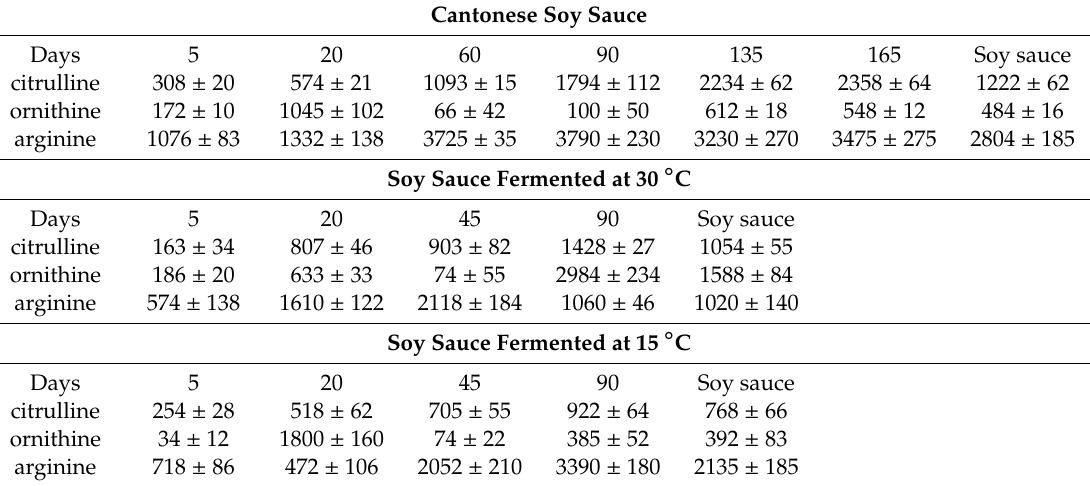
Table 2. Mean value of citrulline, ornithine and arginine ( µ g / mL) in three kinds of soy sauce. Cantonese Soy